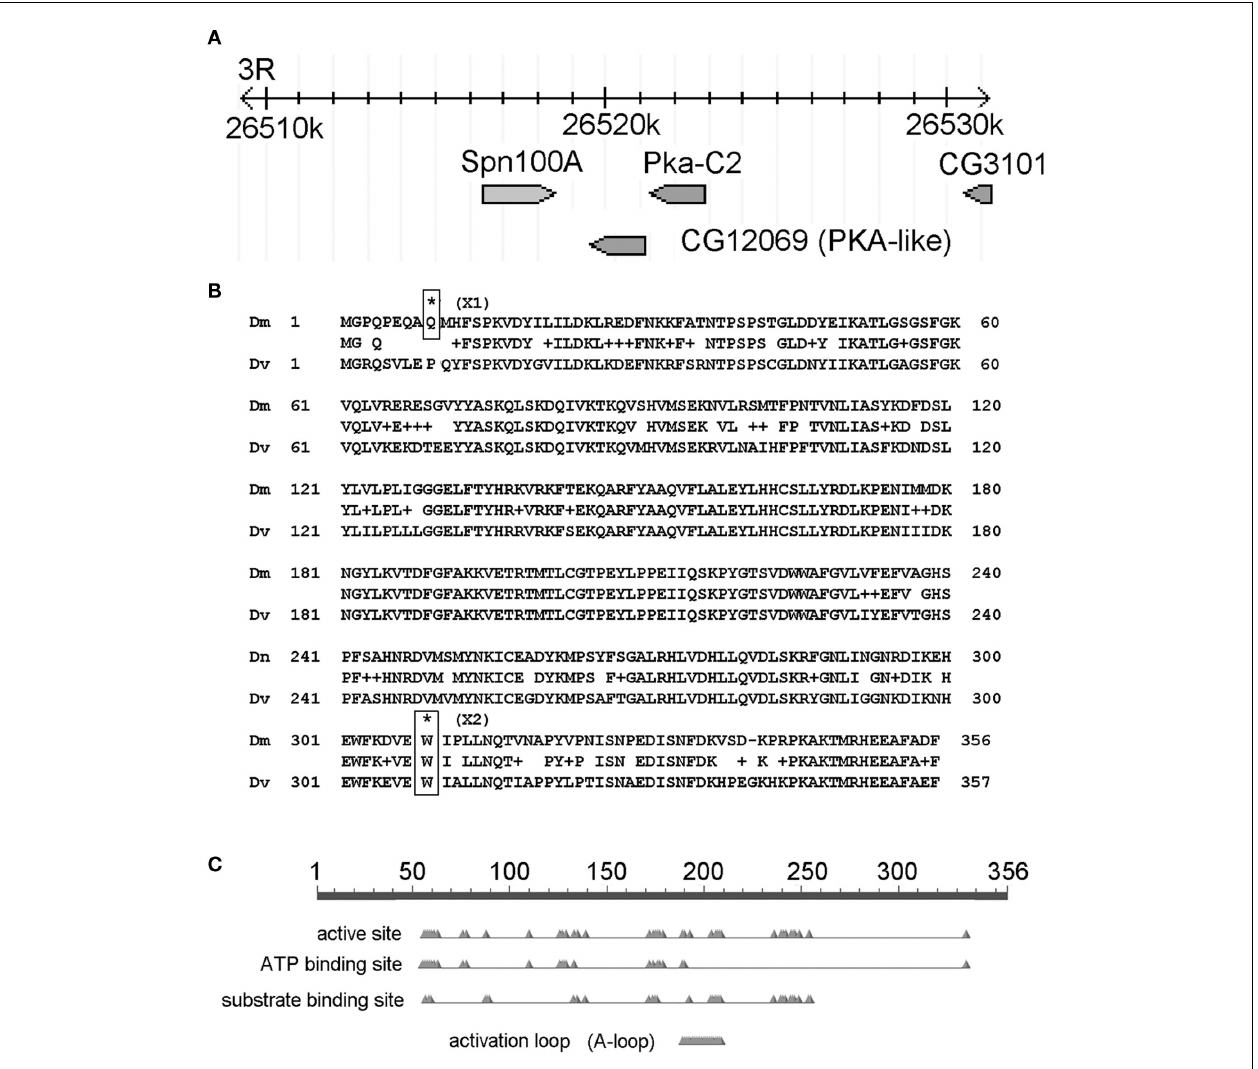
FIGURE 4 |The candidate gene mutated in X1 and X2 is CG12069/Pka-like . (A) Map of the CG12069/Pka-like region on chromosome 3R.The image is adapted from the FlyBase genome browser.The genomic location (26,520k) is indicated in kilobase pairs. (B) Location of X1 and X2 SNPs. (C) Conserved domains in CG12069/Pka-like